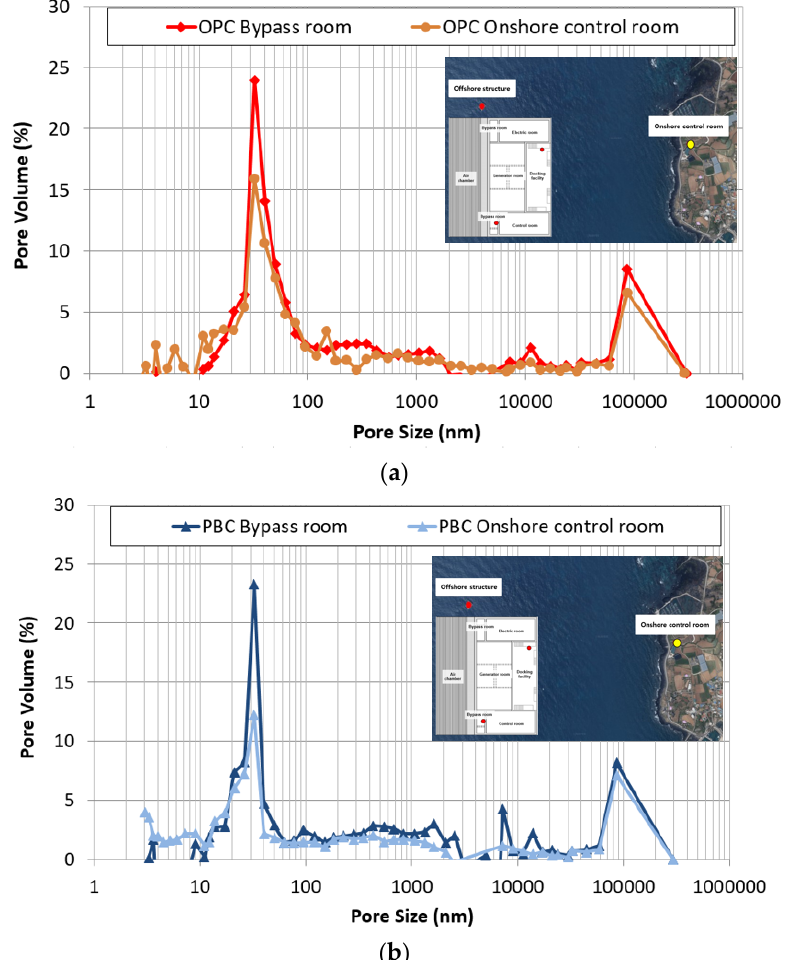
Figure 14. Pore size distribution of concrete at different exposure locations: ( a ) OPC; ( b ) PBC.